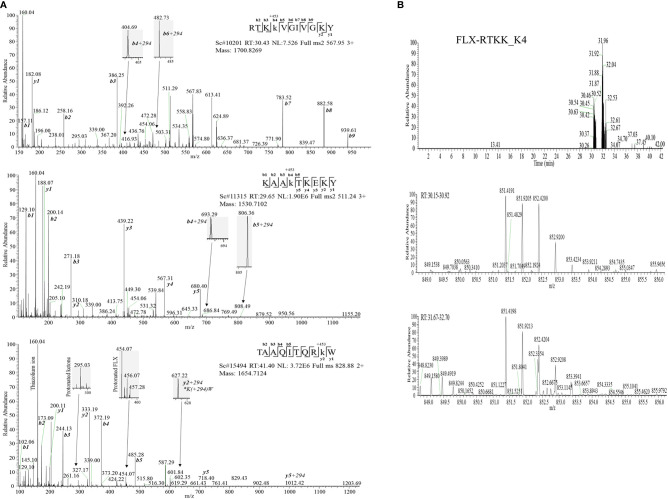
Flucloxacillin modified peptides identified from drug treated HLA-B*57:01 expressing cells. (A) MS/MS spectra of parent ions with characteristic b and y ions, drug fragments (160.04, 295.03, 454.06/07) and diagnostic b+294 fragments identified: RTKK(FLX)VGIVGKY (FLX-RTKK_K4, top panel), KAAK(FLX)LKEKY (FLX-KAA_K4, middle panel), and FLX-modified TAAQITQRK(FLX)W (FLX-TAA_K9, bottom panel). (B) Two FLX-RTKK_K4 isoforms, with different retention time by RP-HPLC (peaks at minute 30.46 and 31.92) (top chromatogram) but identical mass (m/z=851.4191/2+, m/z=567.85/3+ (data not shown)) (mid and low LC-MS1 spectra). All peptides were identified using PEAKS analysis and verified manually.